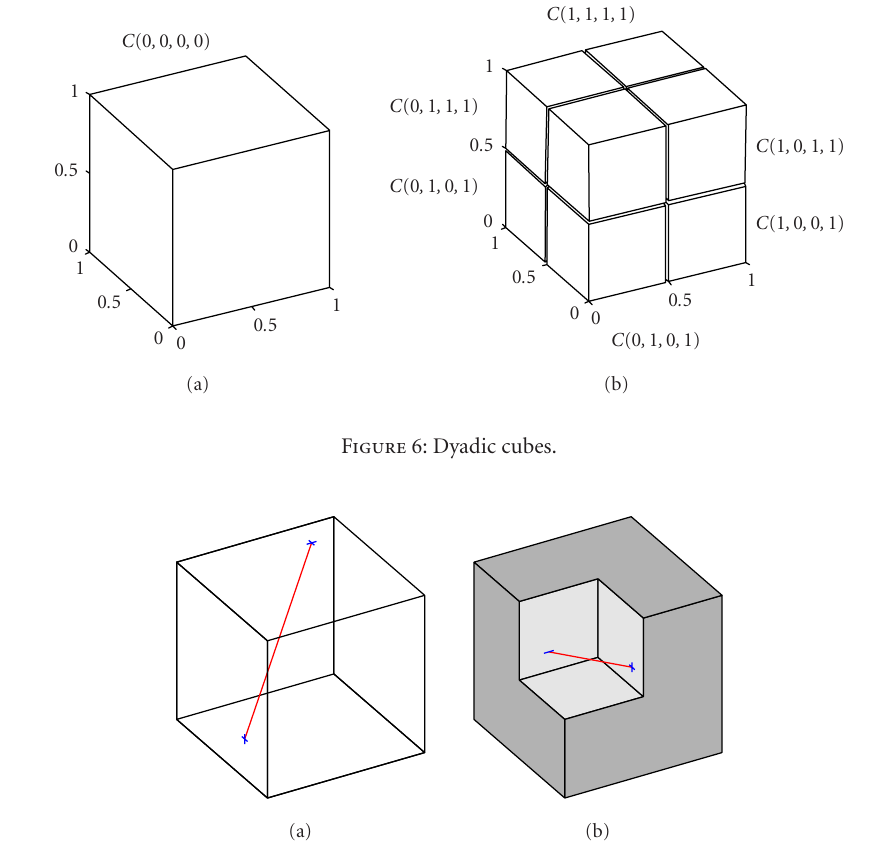
Figure 7: Examples of beamlets at two di ff erent scales: (a) scale 0 (coarsest scale) and (b) scale 1 (next finer scale). dyadic cube at scale j has a side-length of 2 J − j voxels, we get O (2 4( J − j ) ) beamlets associated with the dyadic cube and a to- tal of O (2 4 J − j ) = O ( n 4 / 2 j ) beamlets at scale j . If we sum the number of beamlets at all scales we get O ( n 4 )